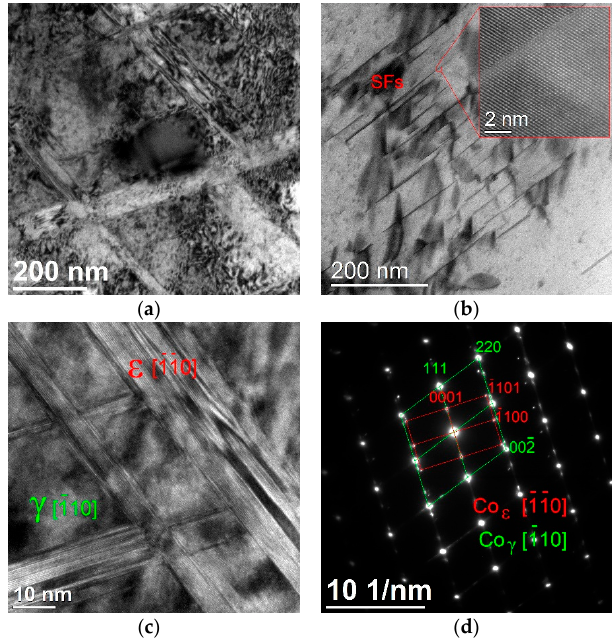
Figure 4. Co-SLS alloy matrix structure. ( a ) STEM-BF image; ( b ) slip bands, STEM-BF image; ( c ) ε phase bands in the γ matrix, TEM image; ( d ) Selected Area Electron Diffraction (SAED). The irregular, elongated particles are evenly distributed, both at the grain boundaries and inside